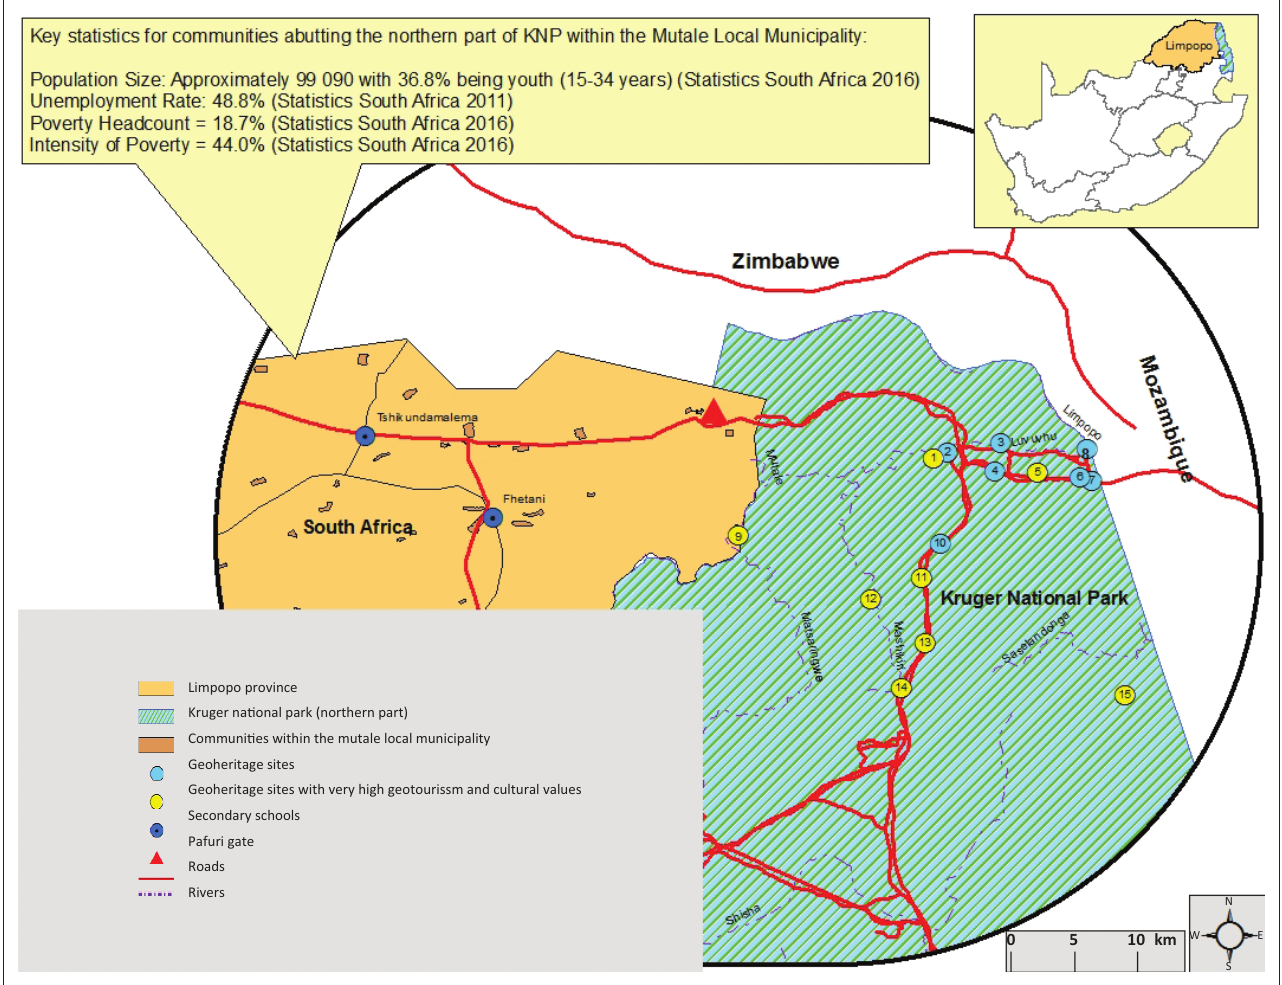
FIGURE 1: Map of the northern part of KNP indicating the study area, geoheritage sites and abutting